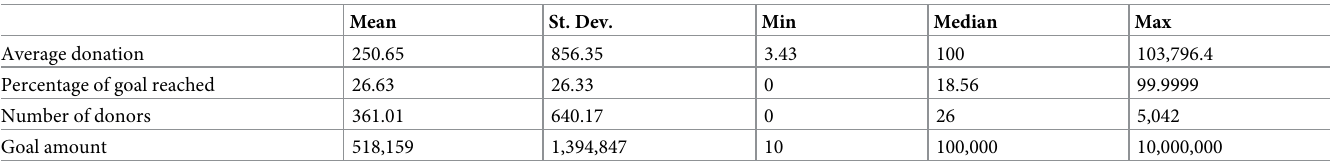
Table 1. Study 1, JGive data summary